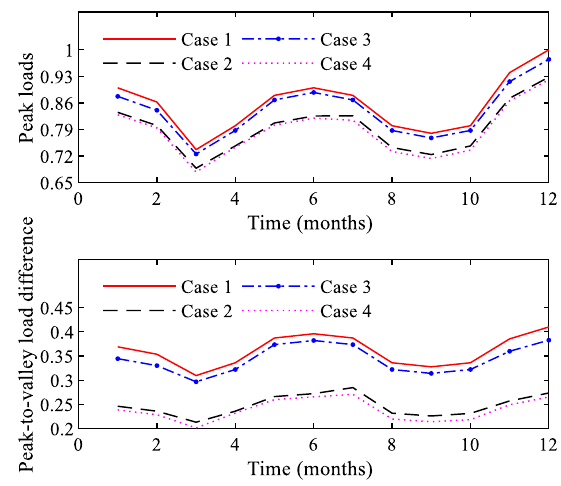
Fig. 10 Distribution of time in different periods